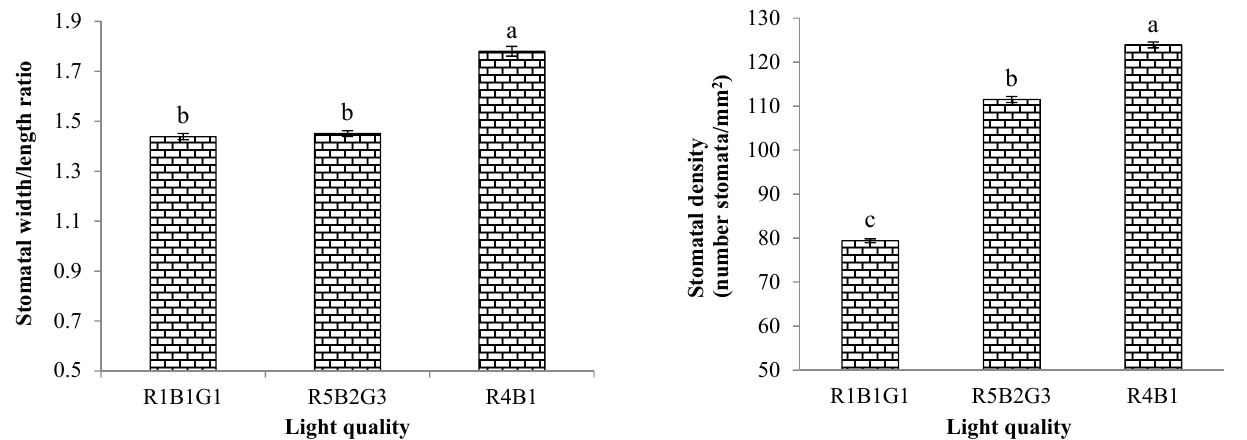
Figure 6. Characteristics of the stomatal cells in the abaxial spinach epidermis leaves for the different light qualities. The error bars show the standard errors. Data were analyzed by R software. Different letters indicate a significant difference among treatments ( p ≤ 0.05).